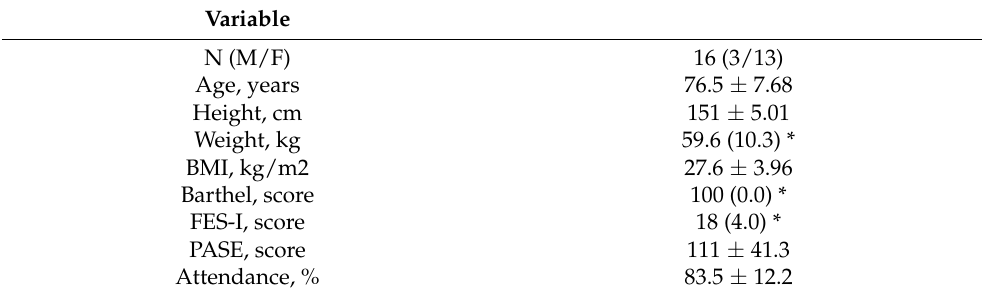
Table 1. Baseline characteristics of the sample.